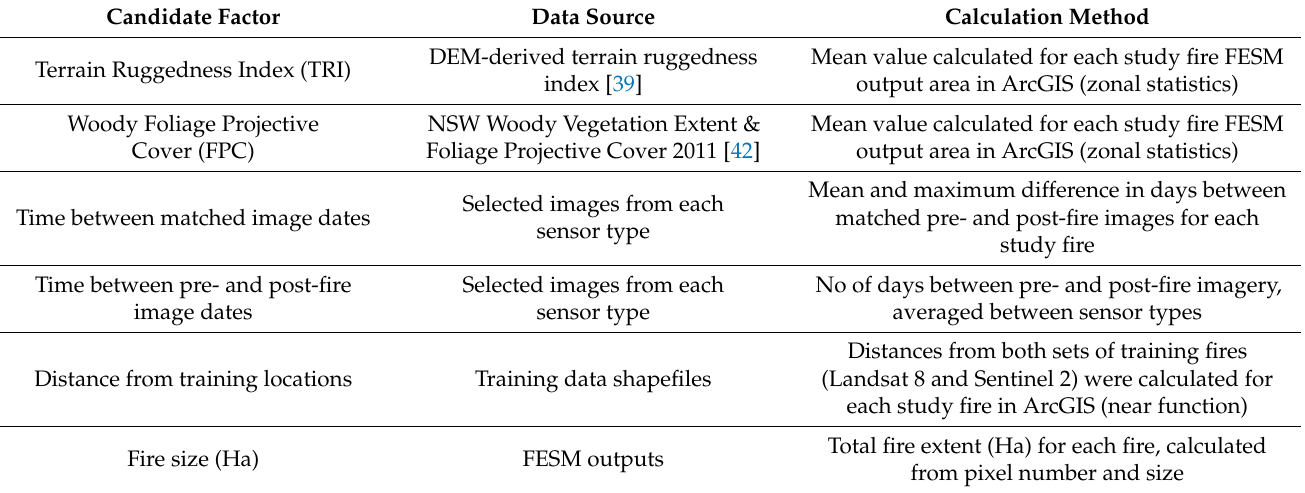
Table 3. Source data and calculation methods for candidate factors impacting sensor output